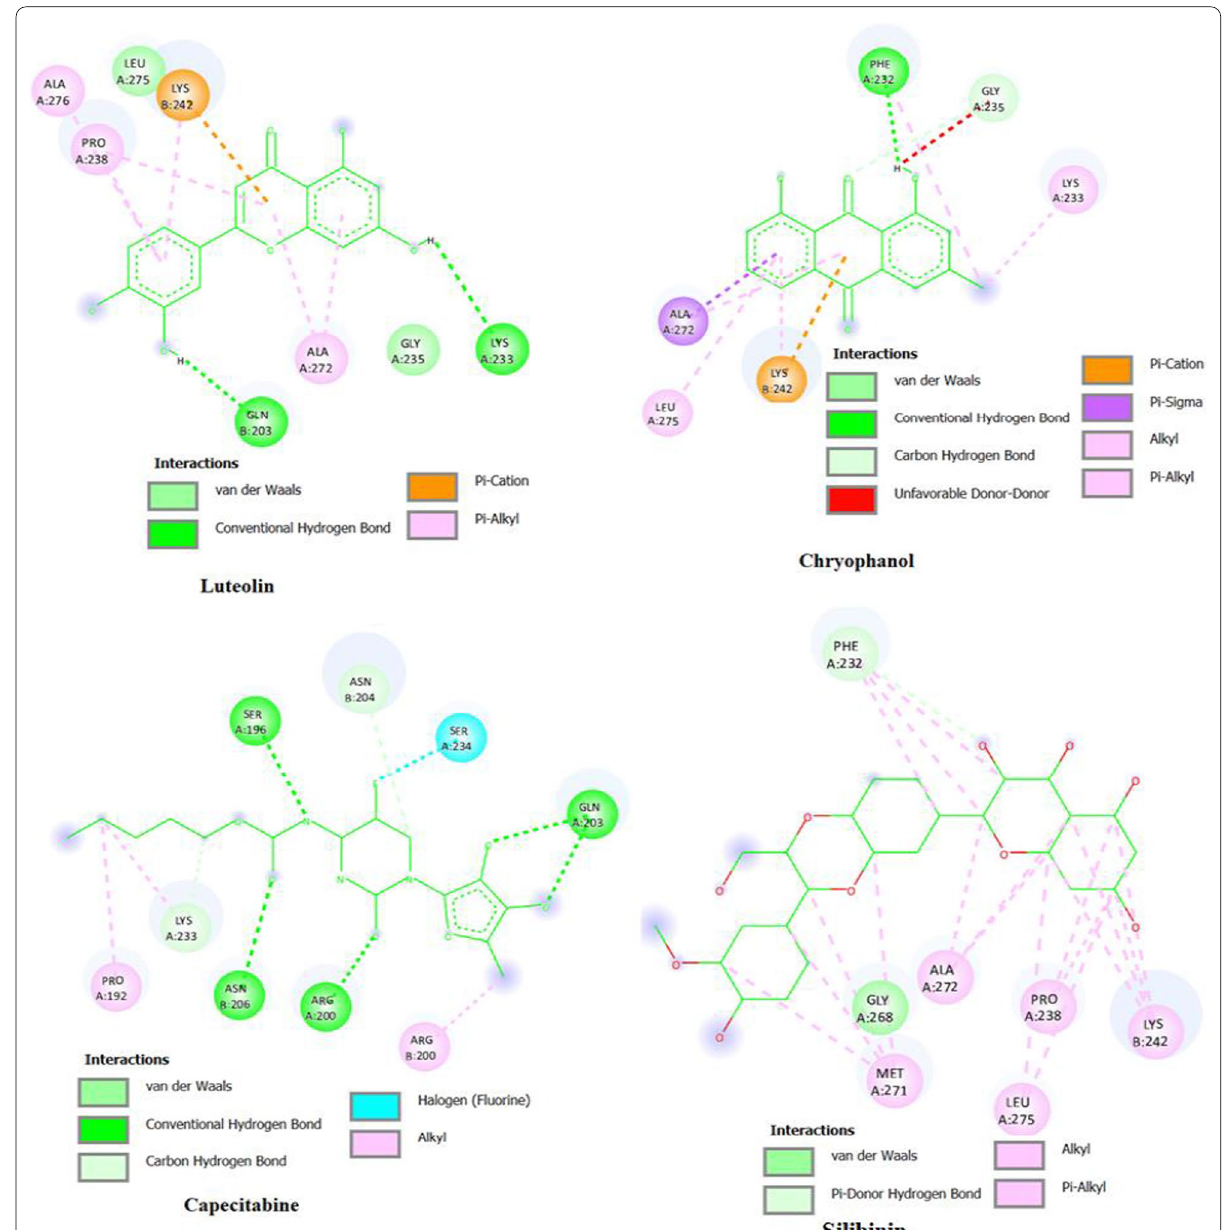
Fig. 5 Binding affinities of β-Catenin protein with phytochemical structure using AutoDock Vina. The 2D structure of protein–ligand interactions is visualized using Discovery studio visualizer and the interactions are predicted based on binding energy (kcal/mol) and hydrogen